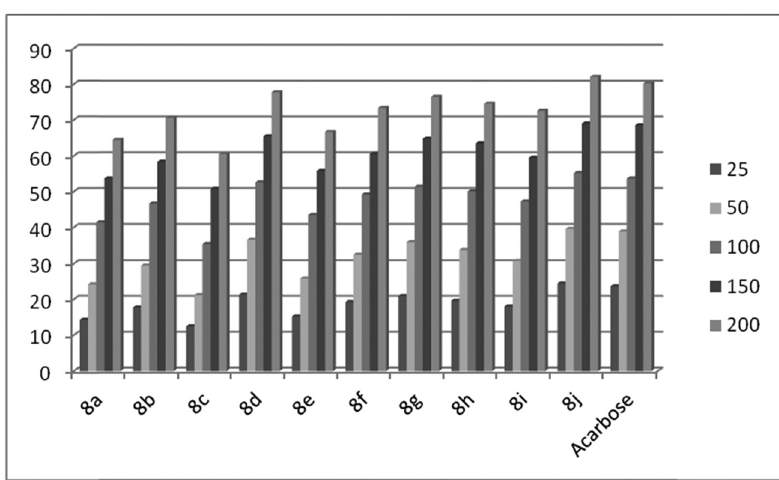
Figure 1: α - Amylase inhibition activity results of compounds 8a – j .